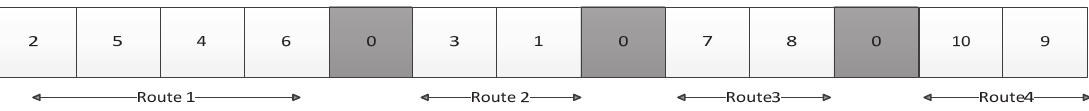
Fig. 2 . Instance of a solution